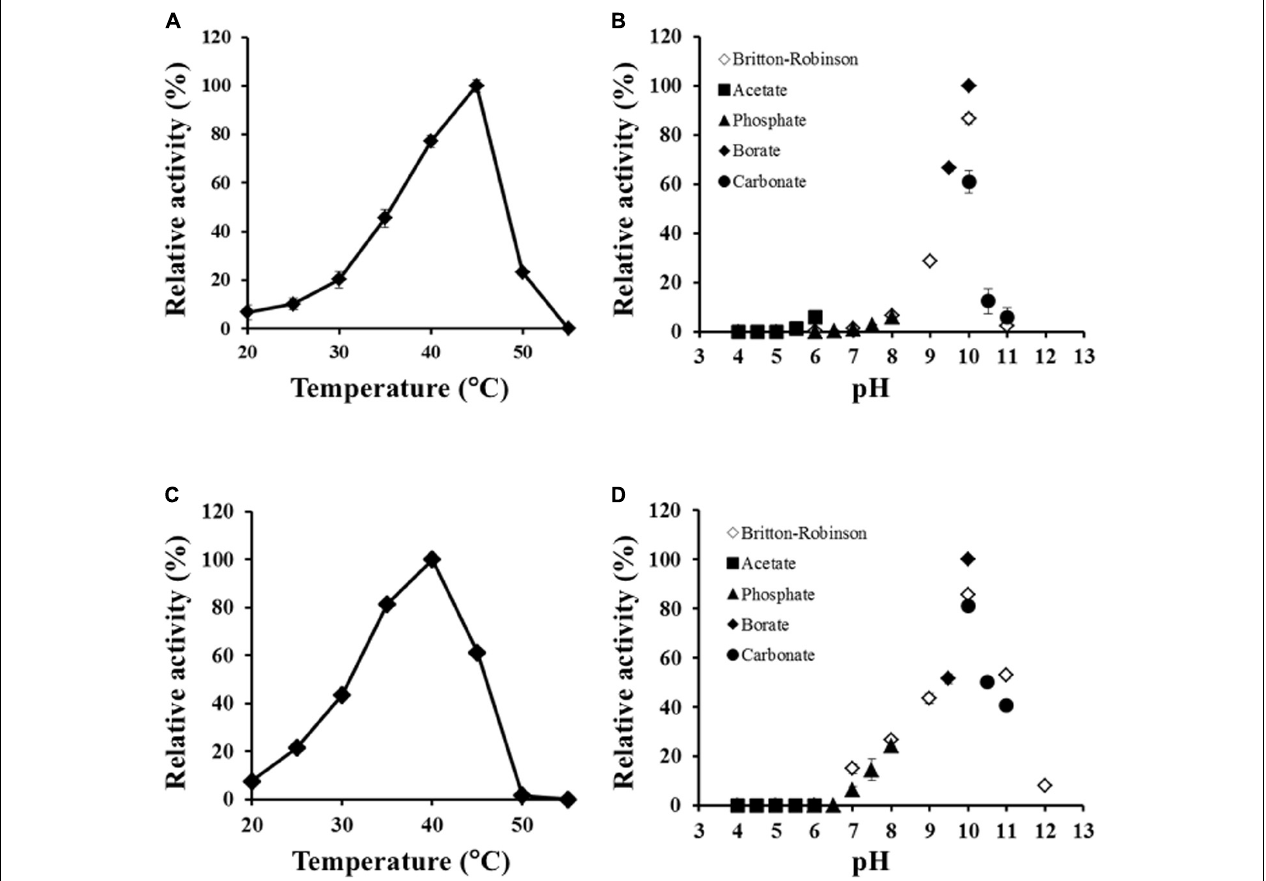
FIGURE 5 | Thermal and pH profiles of racemase and β -lyase reactions. Effect of temperature on racemase (A) and β -lyase (C) reactions at pH 7.5 (50 mM potassium phosphate) and pH dependence of racemase (B) and β -lyase (D) reactions at 30 ◦ C were assessed from 20 to 55 ◦ C and pH from 4.0 to 12.0. The indicated values are the average of triplicate measurements.